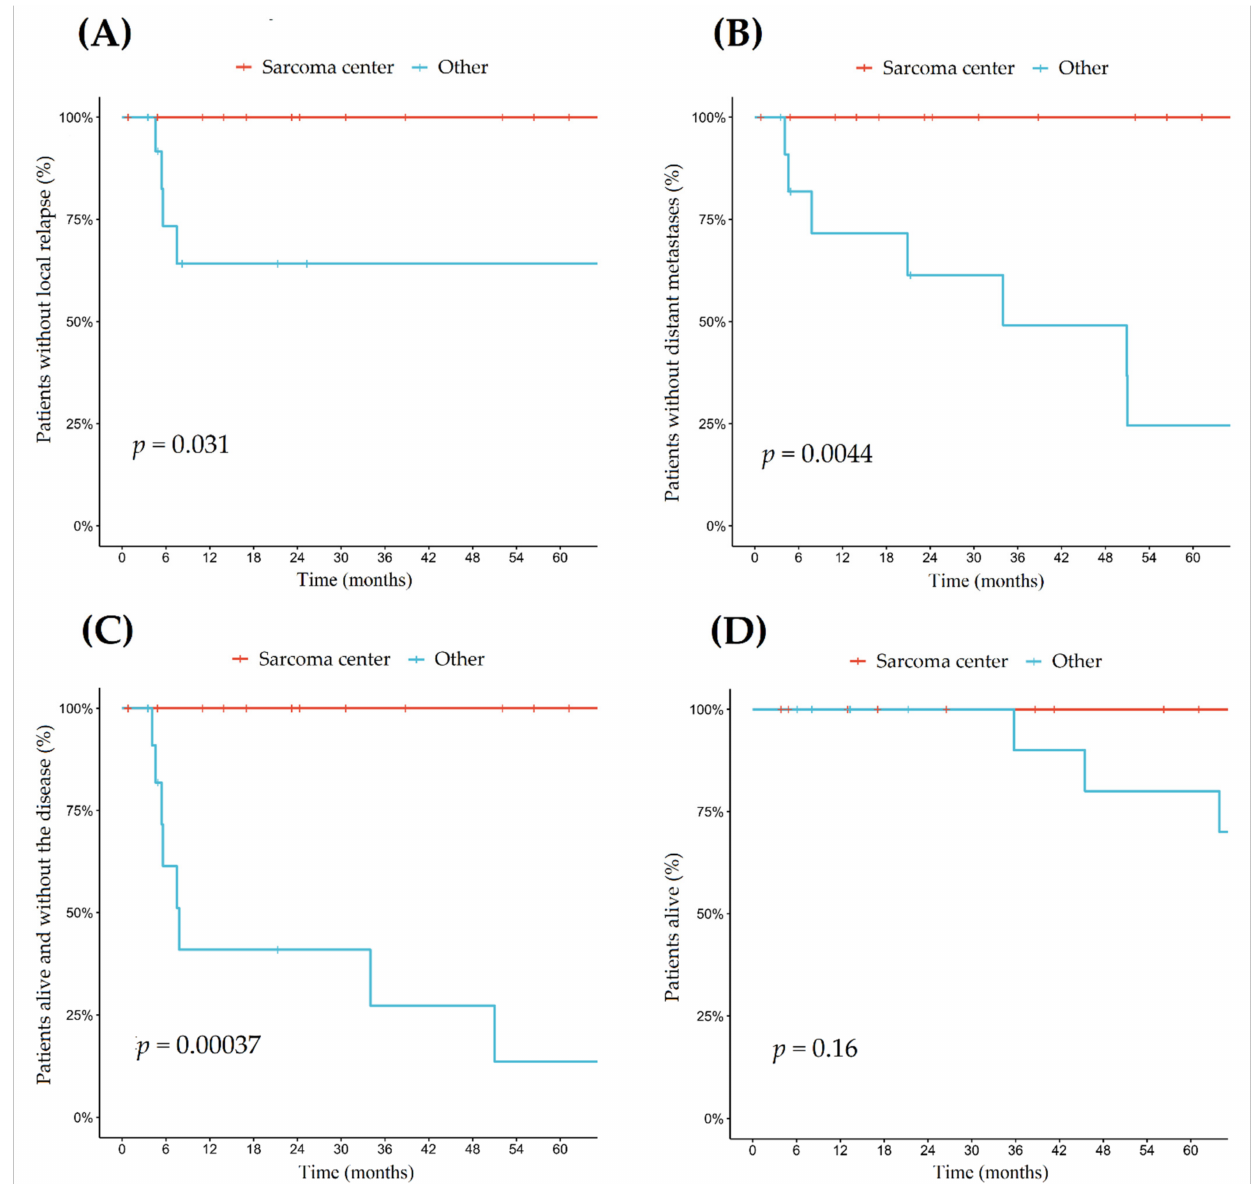
Figure 5. Survival analysis including: ( A ) 5—local recurrence-free survival; ( B ) 5—distant metastases-free survival, ( C ) 5— median disease-free survival, and ( D ) 2—overall